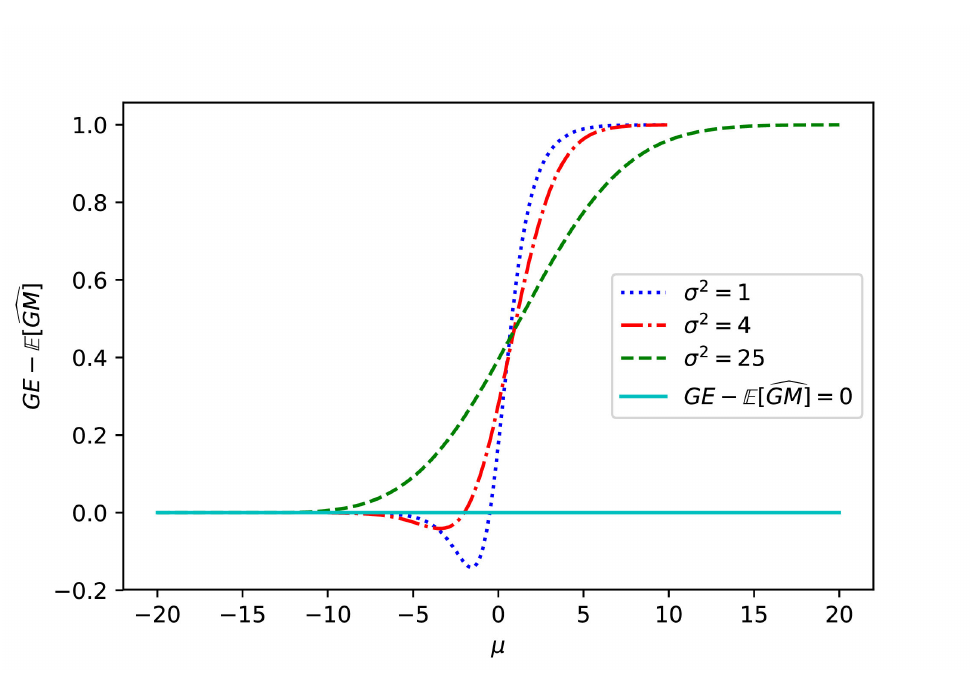
Figure 9: Plot of the GE - E ( GM ) versus mean µ for several variance